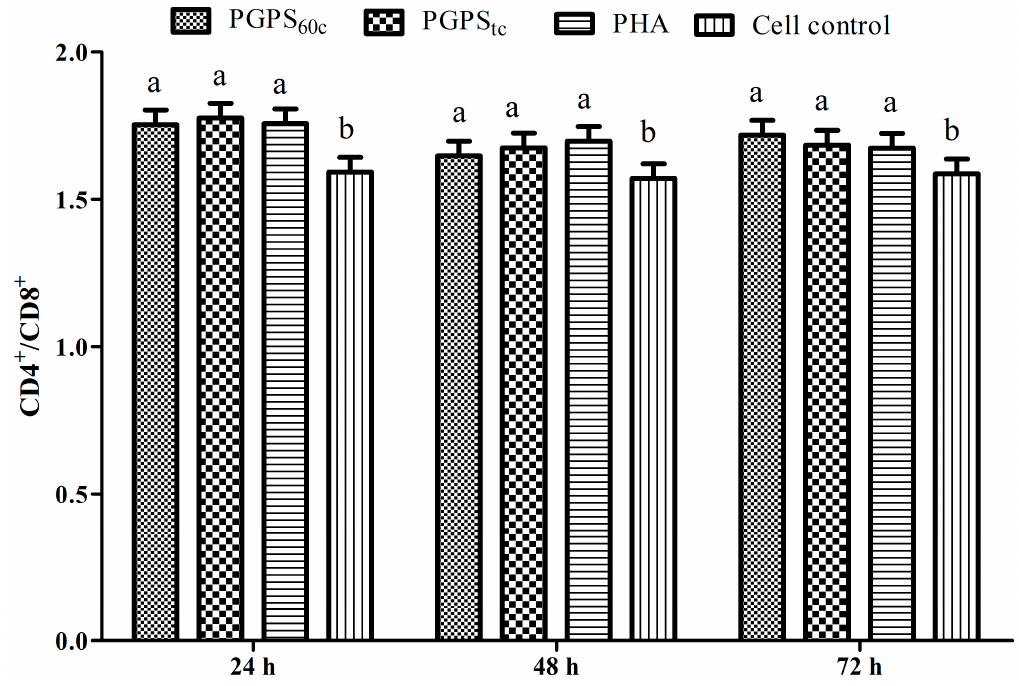
Figure 6. Changes of peripheral blood CD4 + /CD8 + of polysaccharides. The values are presented as means ± SE ( n = 4). a–b Bars without the same superscripts differ significantly ( p < 0.05).